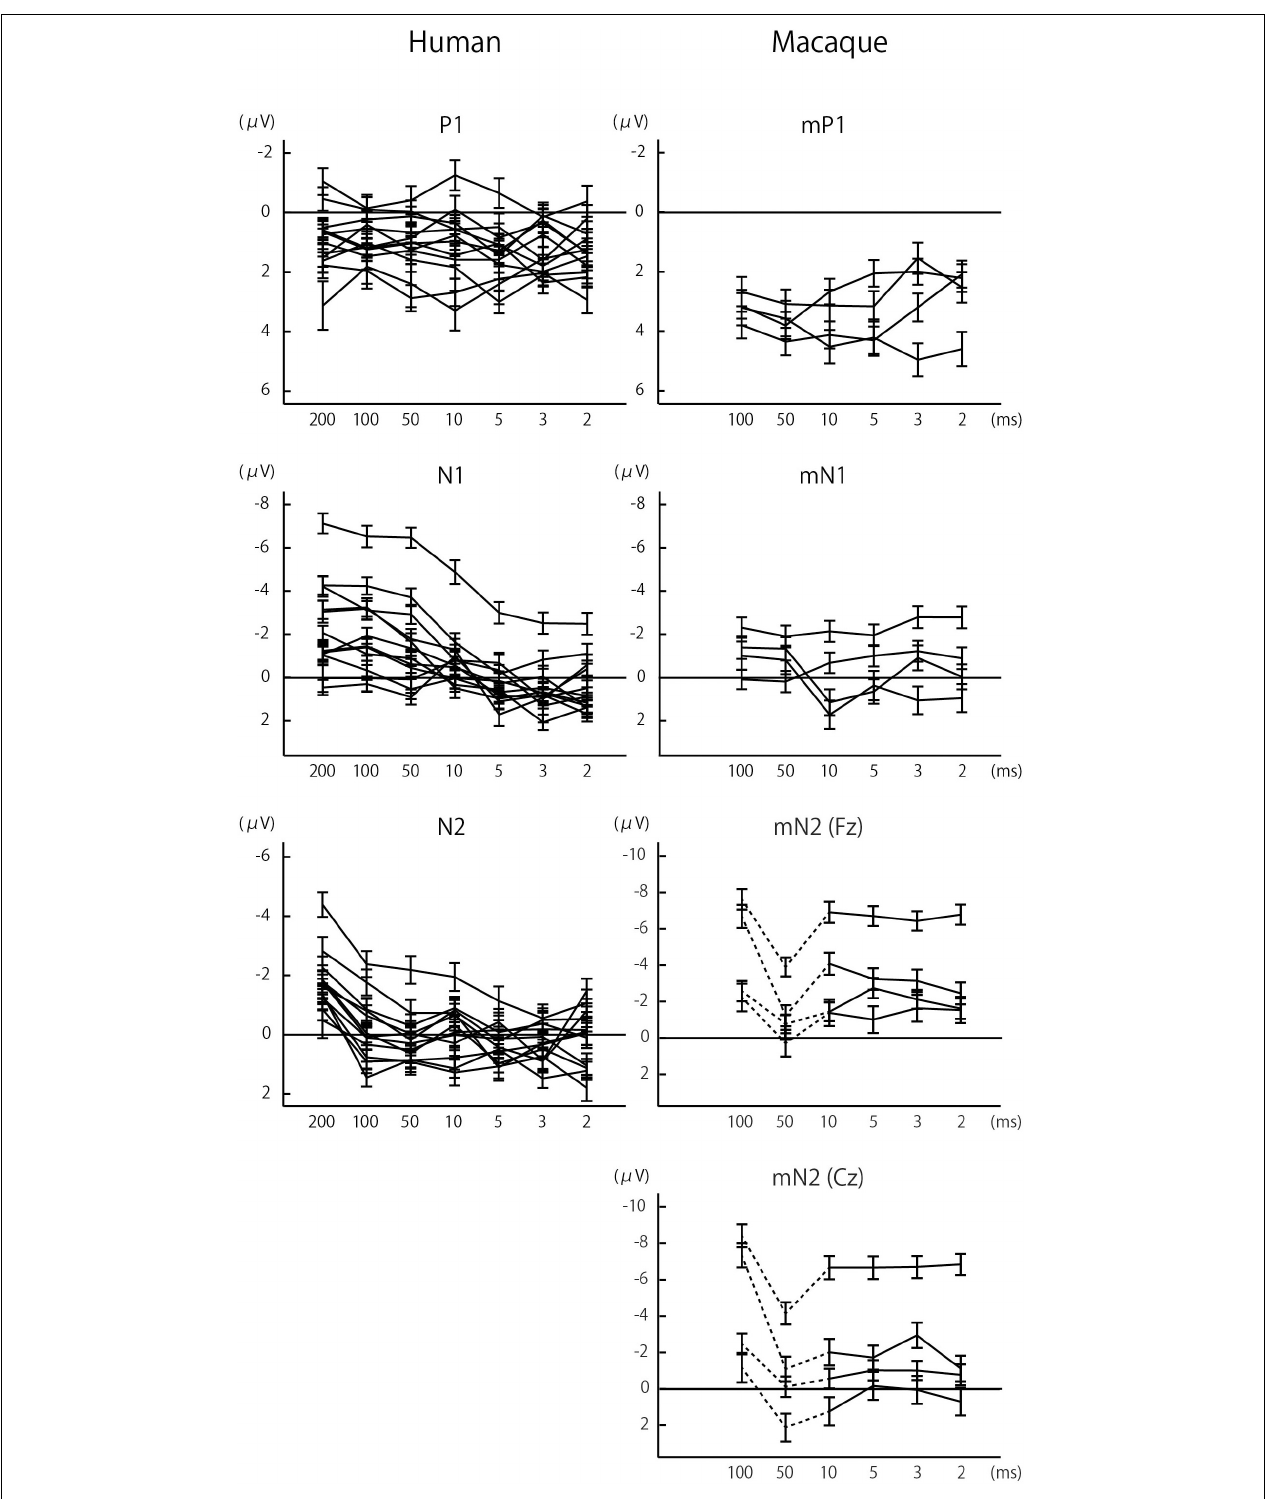
FIGURE 2 | Effects of sound duration on the amplitudes of P1/mP1, N1/mN1, and N2/mN2. The amplitudes of human N1 and N2 significantly decreased with sound duration, p < 0.05 ( Table 1 ), while such effect was less evident with other components. Each line represents a single subject, and the error bars represent standard